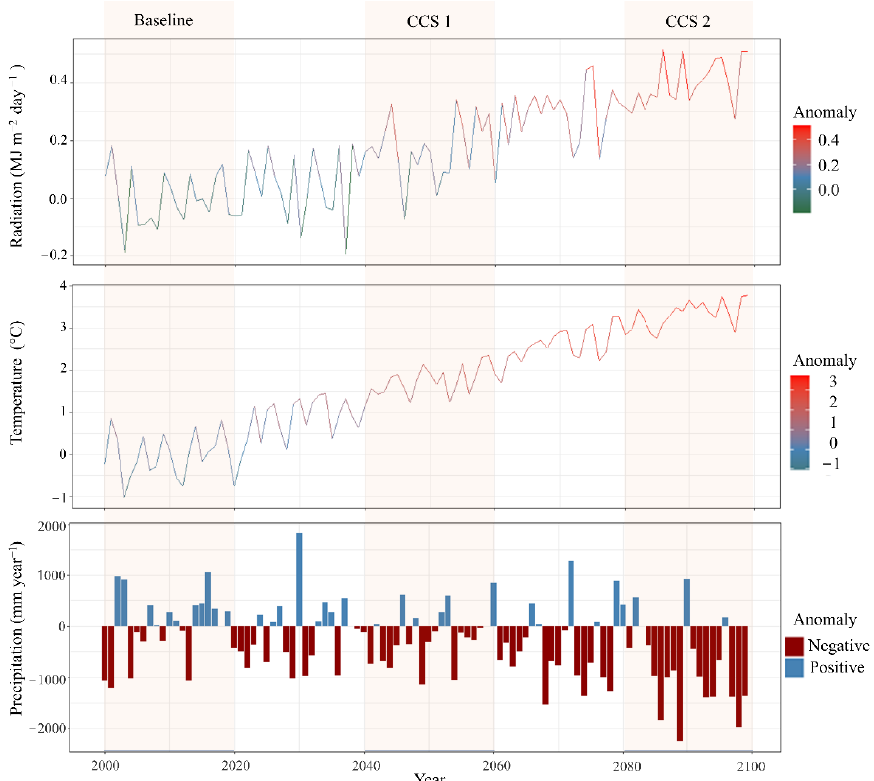
Figure 9. Alteration of the climatological variables of the CCS concerning the Baseline. The three assessment scenarios in the 21st century are shown in yellow boxes (baseline (2000-2019), CCS1 (2040-2059), and CCS2 (2080-2099)). For radiation and temperature, the red scale rises as the anomaly increases compared to the baseline, while precipitation is negative (red) when is lower than the baseline.